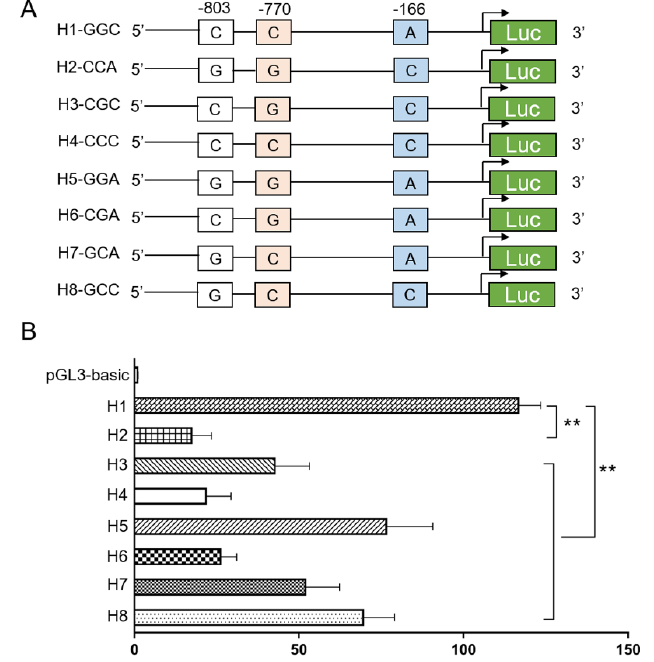
Figure 4. Haplotypes of the SNPs affect promoter activity of the SIRT2 gene. ( A ) Plasmids with their respective eight haplotypes were constructed. ( B ) Promoter activity of the eight haplotypes were detected by a luciferase assay. Data were given as the mean ± SE. ** p < 0.01 shows a significant difference.